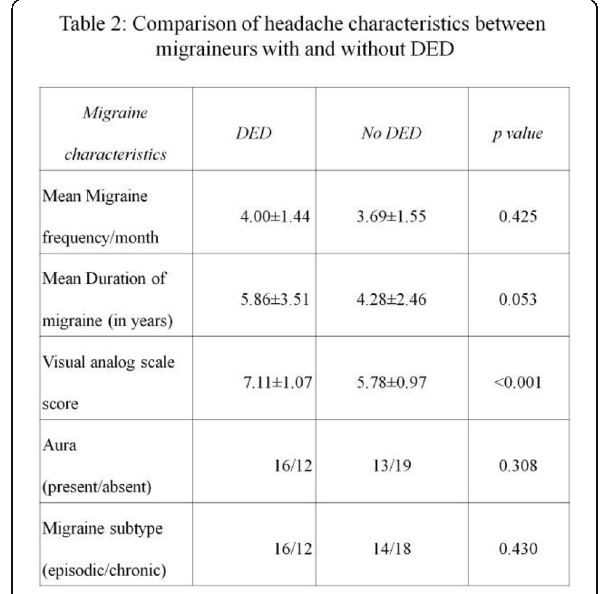
Table 2 (abstract AL05). See text for